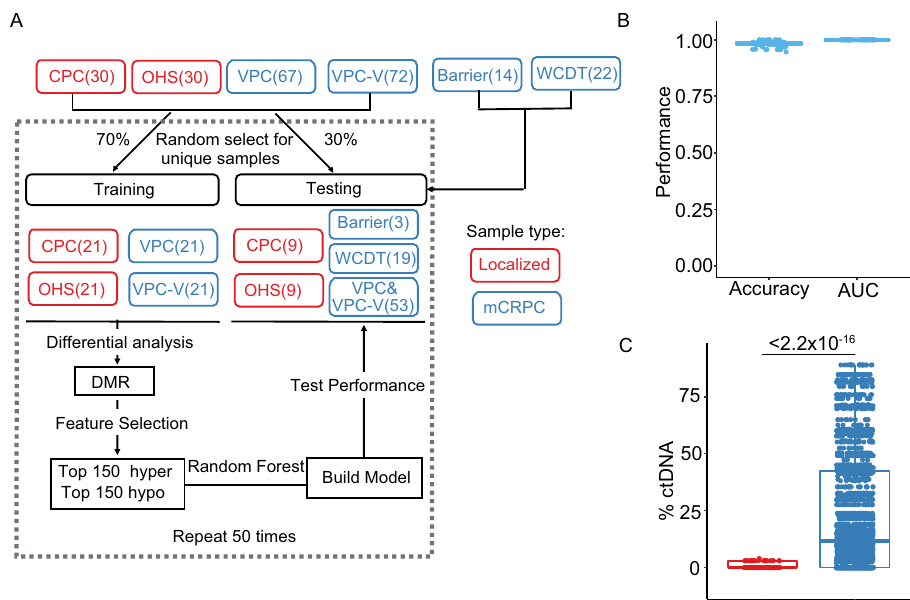
Fig.4|Methylationpro fi lesdistinguishlocalizedfrommetastaticsampleswith high accuracy. A Work fl ow of building a random forest predictor using methyla- tion pro fi les. B Prediction accuracy and area under the receiver operating char- acteristics (AUROC) for methylation pro fi le-based predictor on testing datasets. VPC-V validation samples from the VPC cohort, OHS the Ontario Health Study cohort, DMR differentially methylated region. C %ctDNA distribution in samples